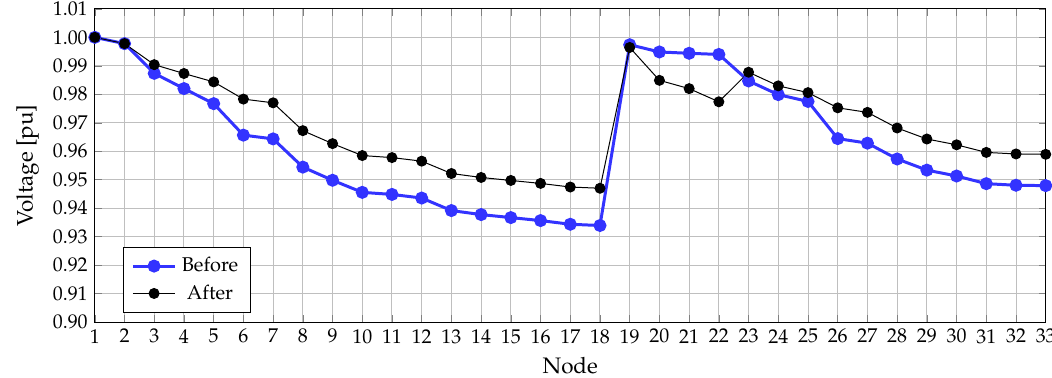
Figure 11. Voltage profile in the 33-nodes test feeder before and after